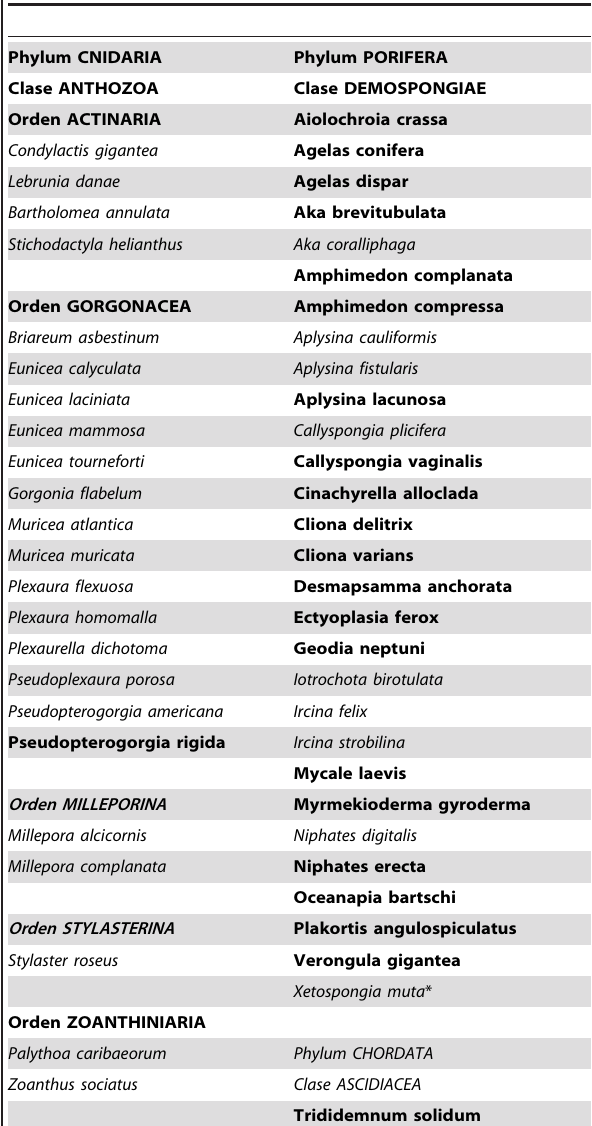
Table 2. List of non-scleractinian benthic fauna recorded in Xcaret in 2005.